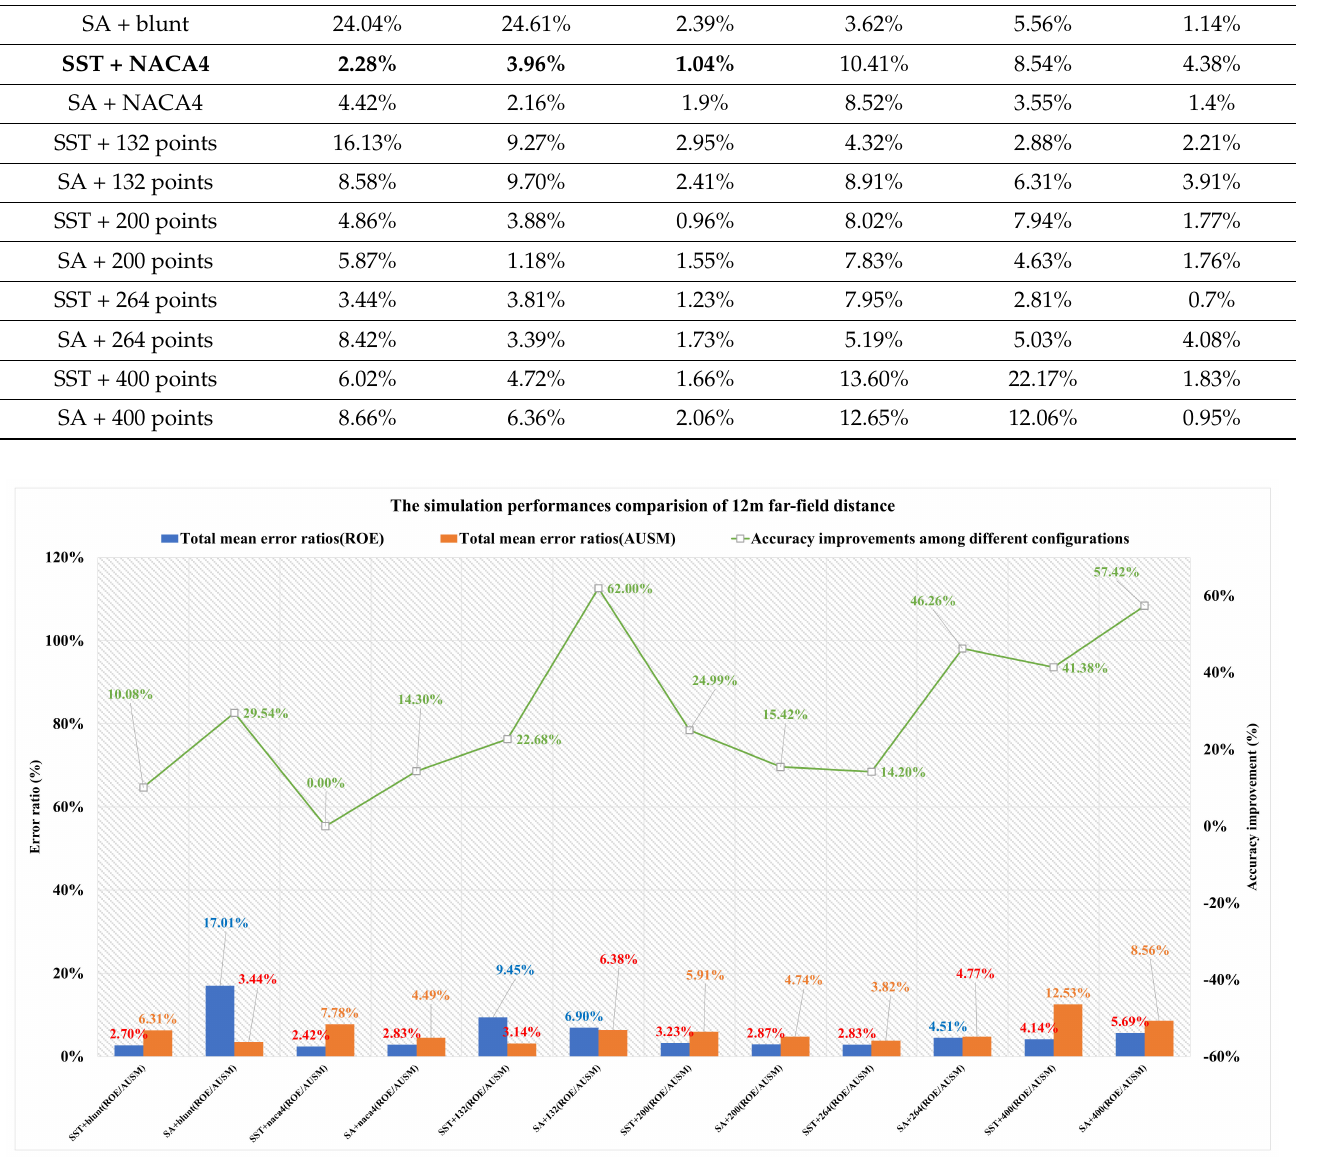
Figure 24. Comparison of the simulation performances of 12 m far-field distance under different simulation